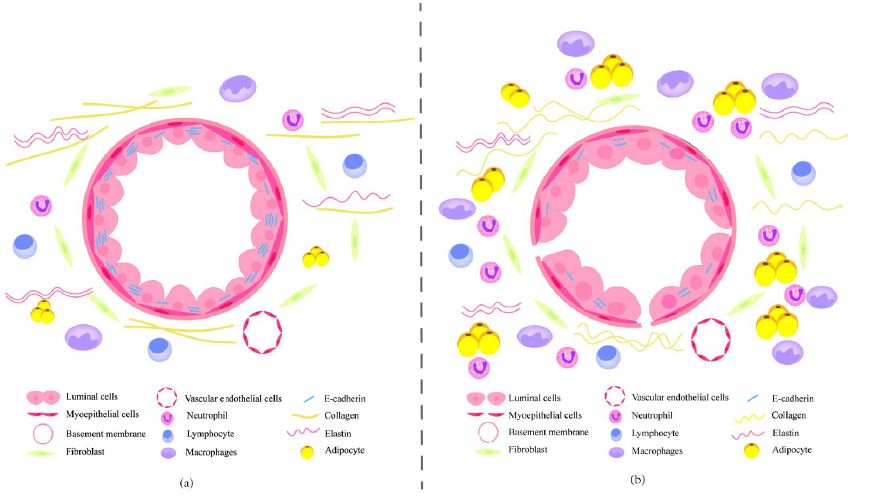
Figure 1. ( a ) Mammary microenvironment (young). The mammary microenvironment contains the extracellular matrix (ECM), immune cells, fibroblasts, adipocytes, and endothelial cells. E-cadherins are highly expressed in the membrane of luminal cells. ( b ) Mammary microenvironment (aged). Aging causes collagen to become thinner and curvier, forming a denser collagen mesh and increas- ing the stiffness of the extracellular matrix. The expression of E-cadherins decreases in the mem- brane of luminal cells.